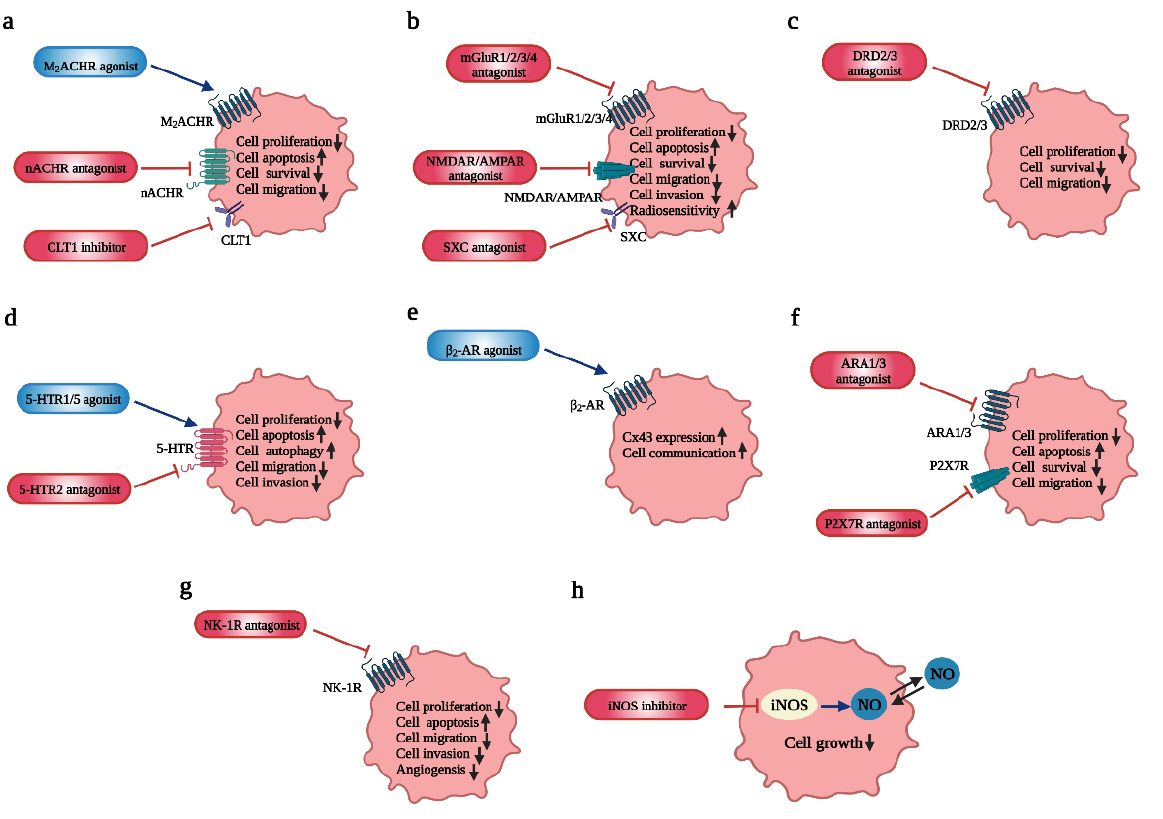
Figure 3. Potential targets of neurotransmitter-related drugs in GBM. Different neurotransmitters and their potential targets for GBM treatment. ( a ) ACh and M2AChR, nAChR, CTL1. ( b ) Glu and mGluR1/2/3/4, NMDAR/AMPAR, SXC. ( c ) DA and DRD2/3. ( d ) 5-HT and 5-HTR1/2/5. ( e ) NE and β 2-AR. ( f ) ATP and ARA1/3, P2X7R. ( g ) SP and NK-1R. ( h ) NO and iNOS inhibitor.